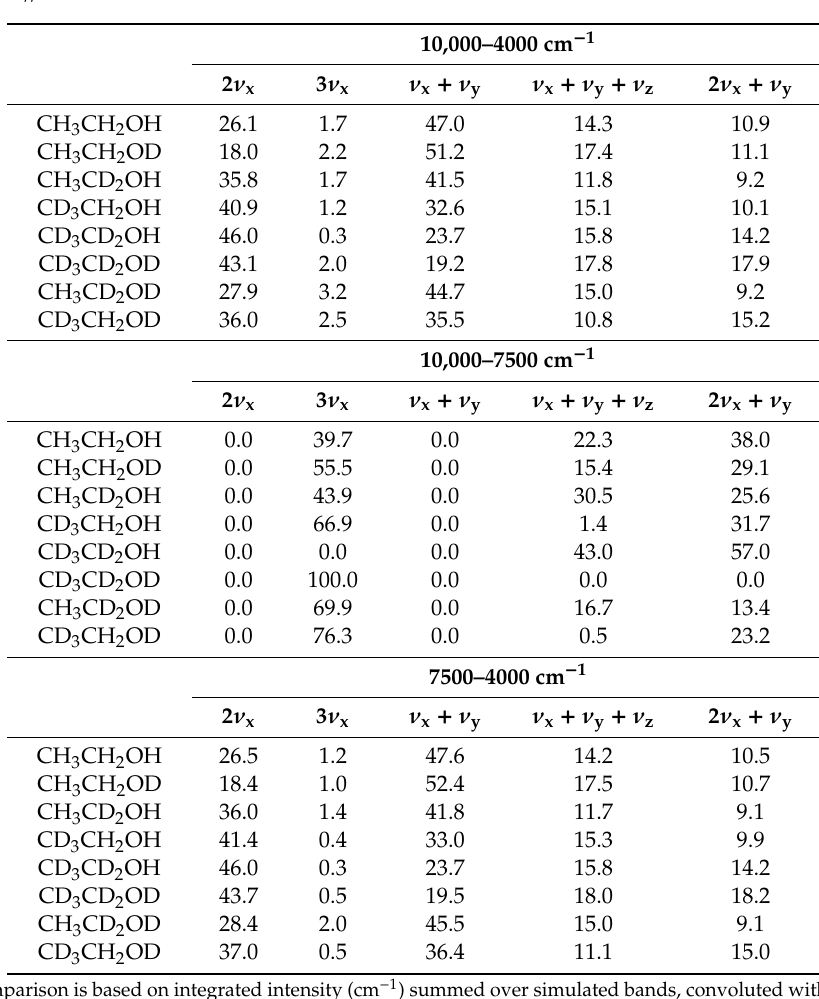
Table 10. Contributions (in %) from the first and second overtones as well as binary and ternary combinations into NIR spectra of ethanol isotopomers based on GVPT2 // B2PLYP-GD3BJ / def2-TZVP // CPCM calculations.